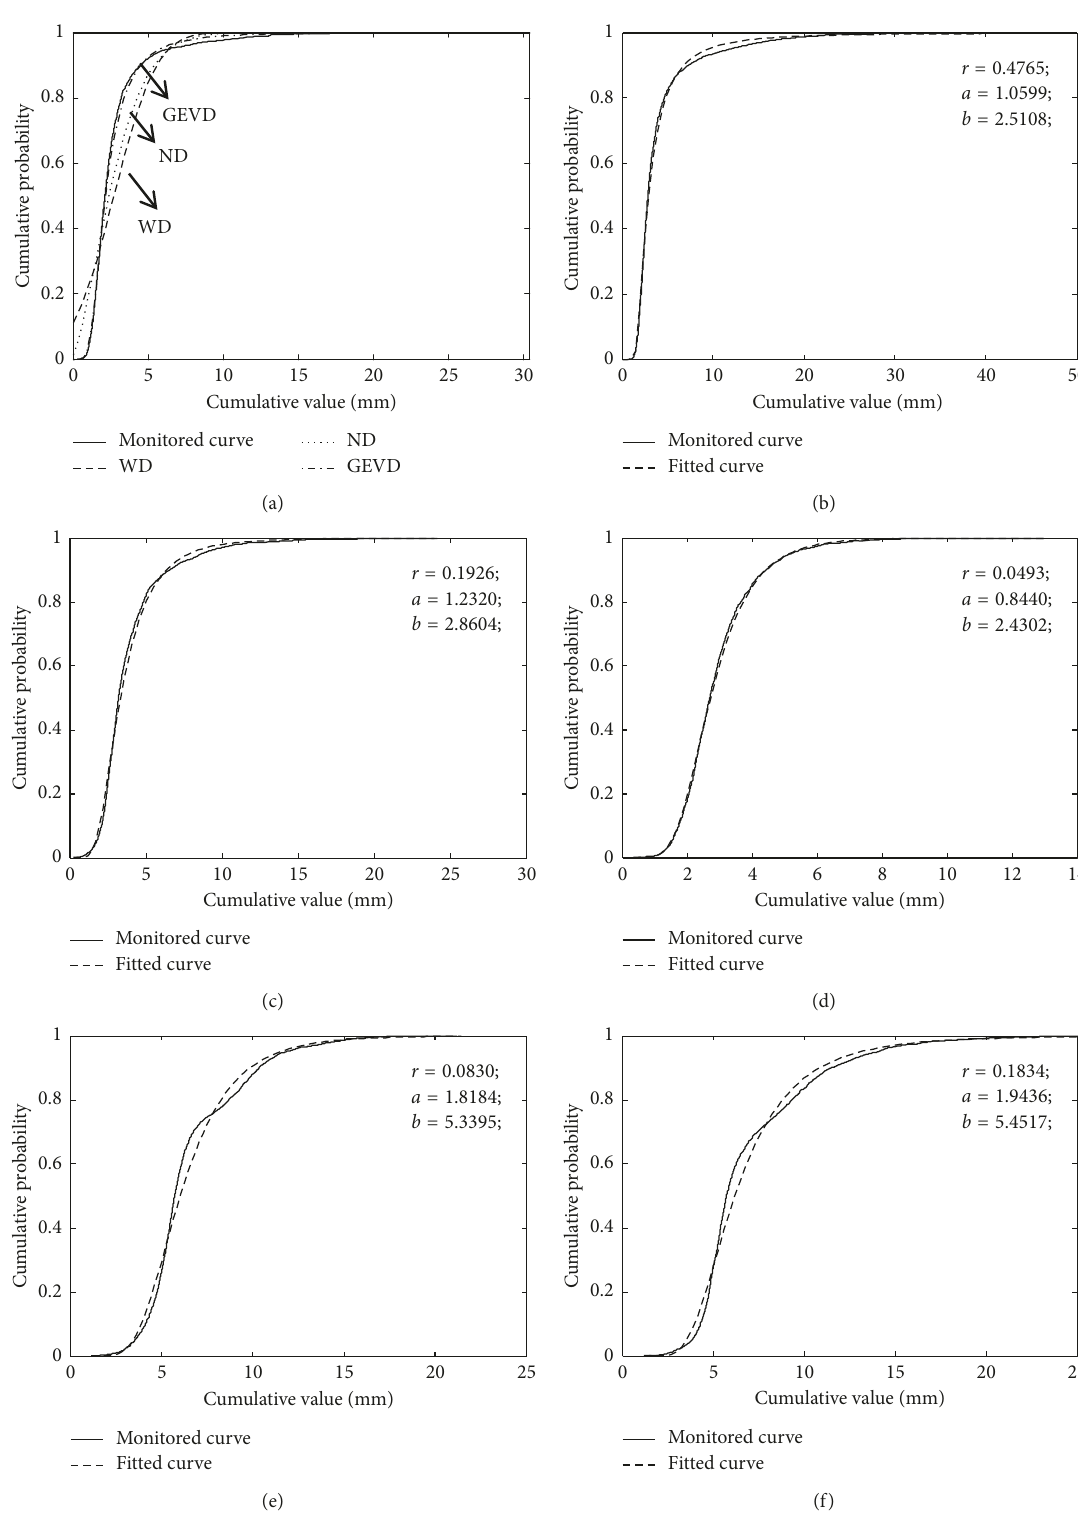
− N and N 1 , u 6 , u